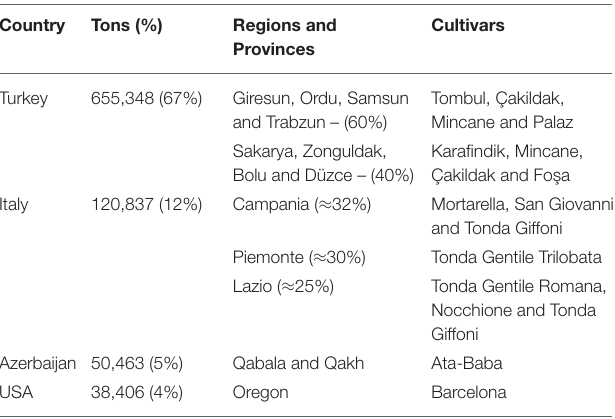
TABLE 1 | Summary of the four main hazelnut producers with the regions of interest and dominant cultivars for each region.